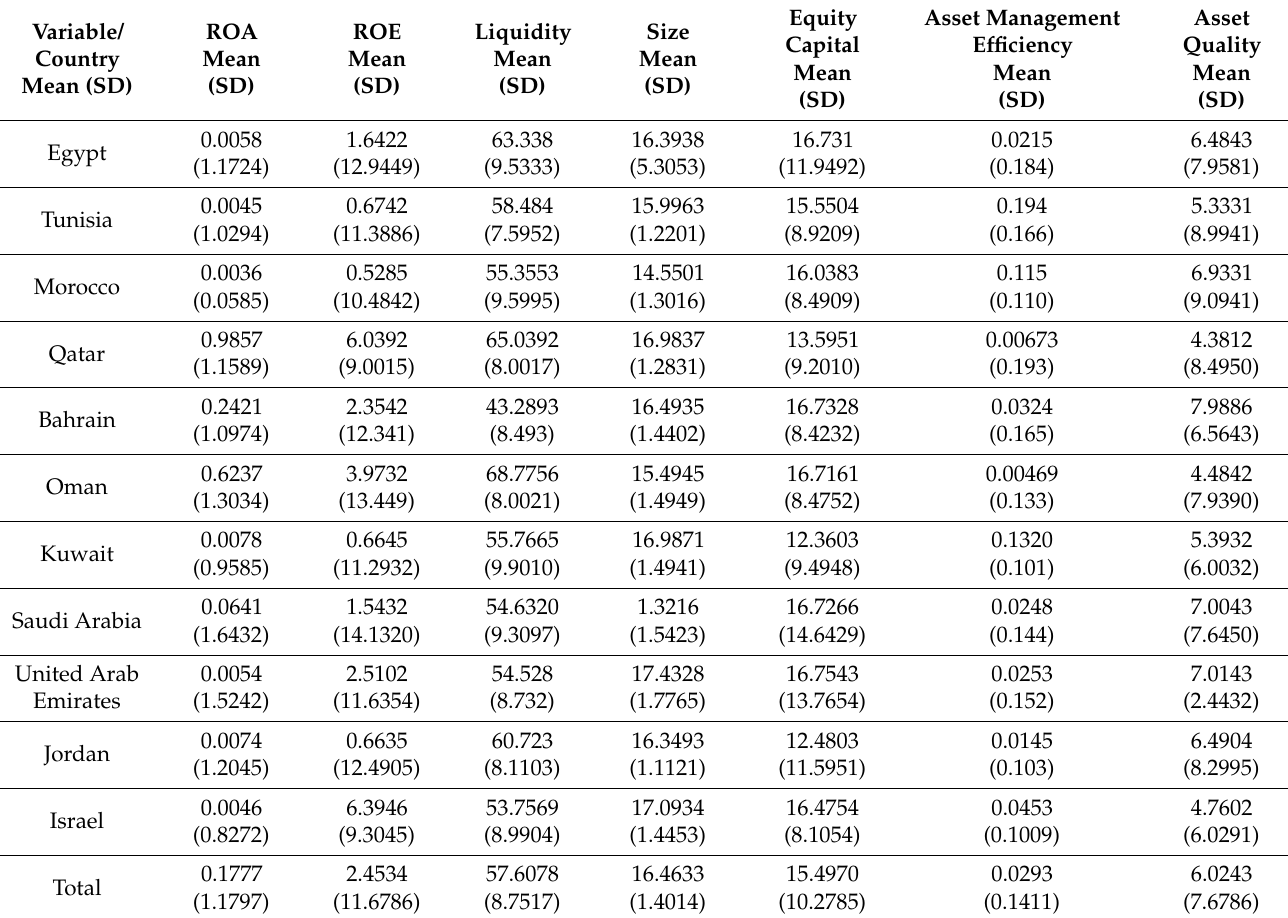
Table 1. Descriptive statistics (means and standard